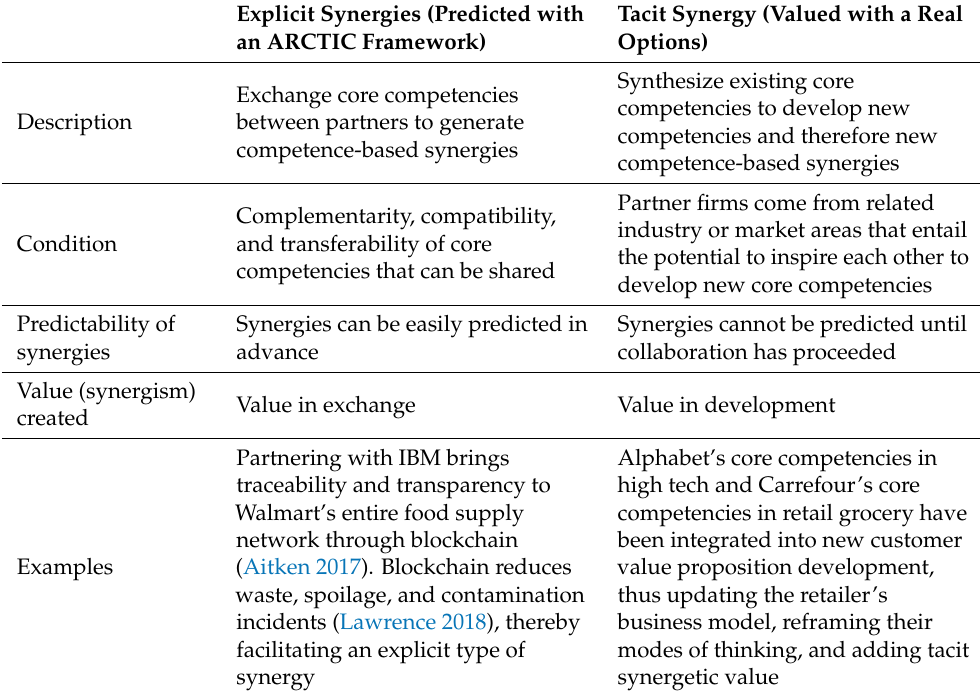
Table 1. A comparison between the prediction of explicit synergies and valuation of tacit